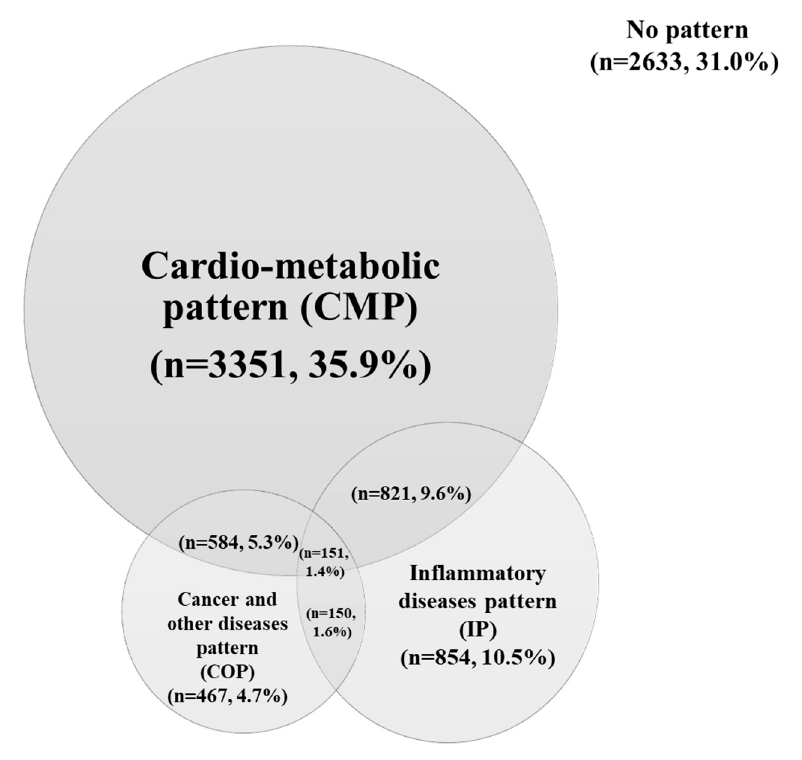
Figure 2. Overlapping multimorbidity patterns among adults aged 19–64 years in South Korea. All analysis accounting for the complex weights were used. Values are presented as n , %.